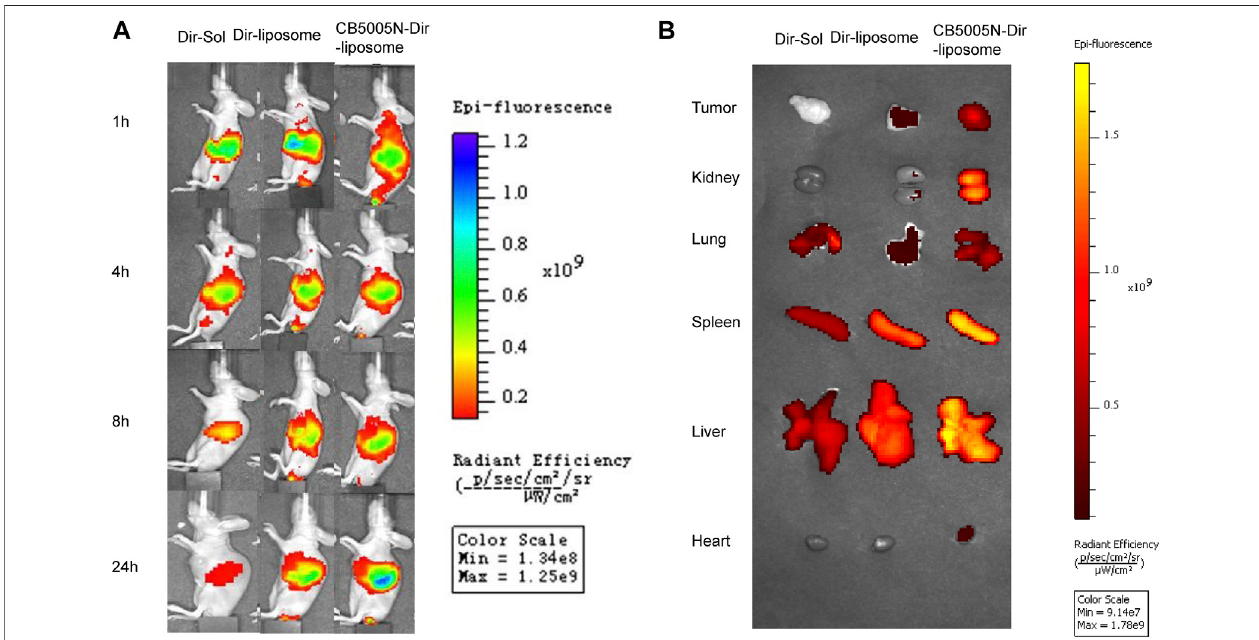
FIGURE 5 | (A) Comparison of tumor fl uorescence intensity in tumor bearing mice before and after drug administration; (B) The pictures of the tumors and organs removed from mice after 24 h ( n = 3).